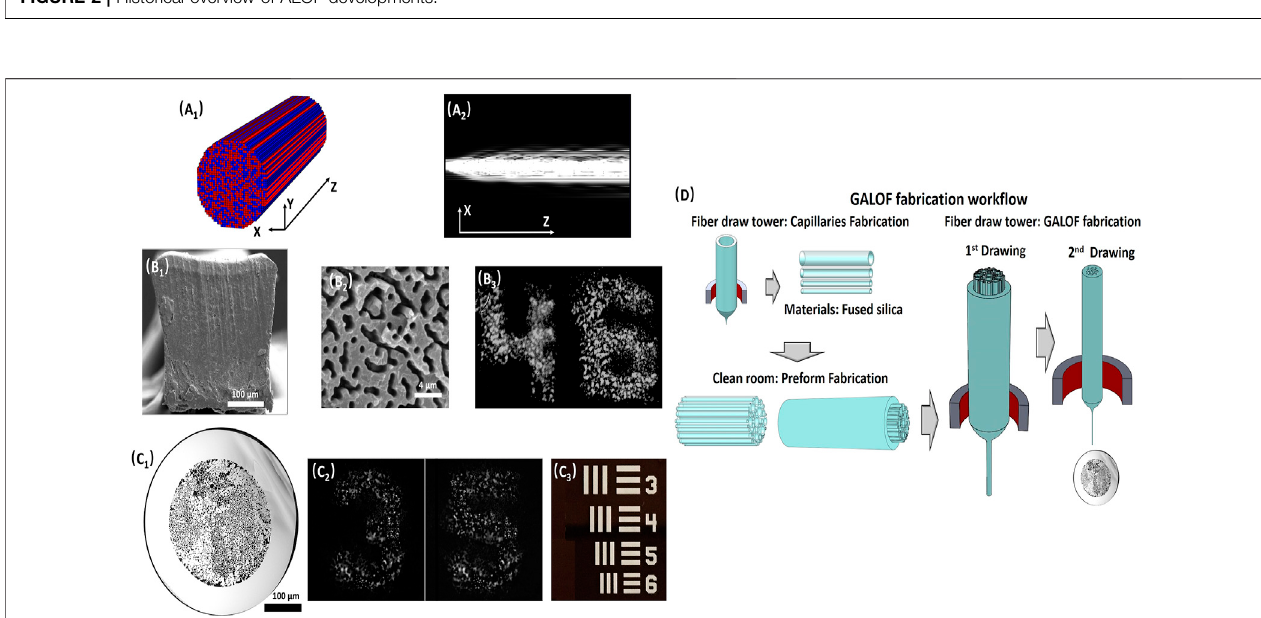
FIGURE3|(A 1 ) Schematicofaquasi-2DdisorderedwaveguidestructureforobservationoftransverseAndersonlocalization;eachpixelisrandomlyassignedbya refractiveindexofn 1 orn 2 (redorbluecolor)withequalprobabilities. (A 2 ) CrosssectionofaGaussianbeampropagationprocessinthedisorderedwaveguide. (B 1 ) SEM imageofPALOFcrosssection. (B 2 ) SEMimageofazoomed-inareaofthePALOFcrosssection.Thesampleisexposedtoasolventtodifferentiatebetweenpolymethyl methacrylate (PMMA) and polystyrene (PS) polymer. The darker regions are PMMA; the Material fi lling fraction is ∼ 50%; The feature size is ∼ 0.9 µm. (B 3 ) Transported images of numbers “ 4 ” and “ 6 ” through a 5-cm-long PALOF sample. The numbers are elements from group 3 in the 1951 USAF resolution test chart. (C 1 ) SEM image of GALOF cross section: white areas are fused silica and black areas are air holes; the material fi lling fraction is ∼ 28.5%; The feature size is ∼ 1.6 µm. (C 2 ) Transportedimagesofnumbers “ 3 ” and “ 5 ” througha4.5-cm-longGALOFsample.Thenumbersareelementsfromgroup3inthe1951USAFresolutiontestchart. (C 3 ) Elements in the 1951 USAF resolution test chart. (D) GALOF fabrication process. (A 1, A 2 ) , (B 1 ,B 2 ) , and (C 1 – C 3 ) are adapted with permission from [42, 86], and [103] © The Optical Society, respectively. (B 3 ) is adapted with permission [98] ©